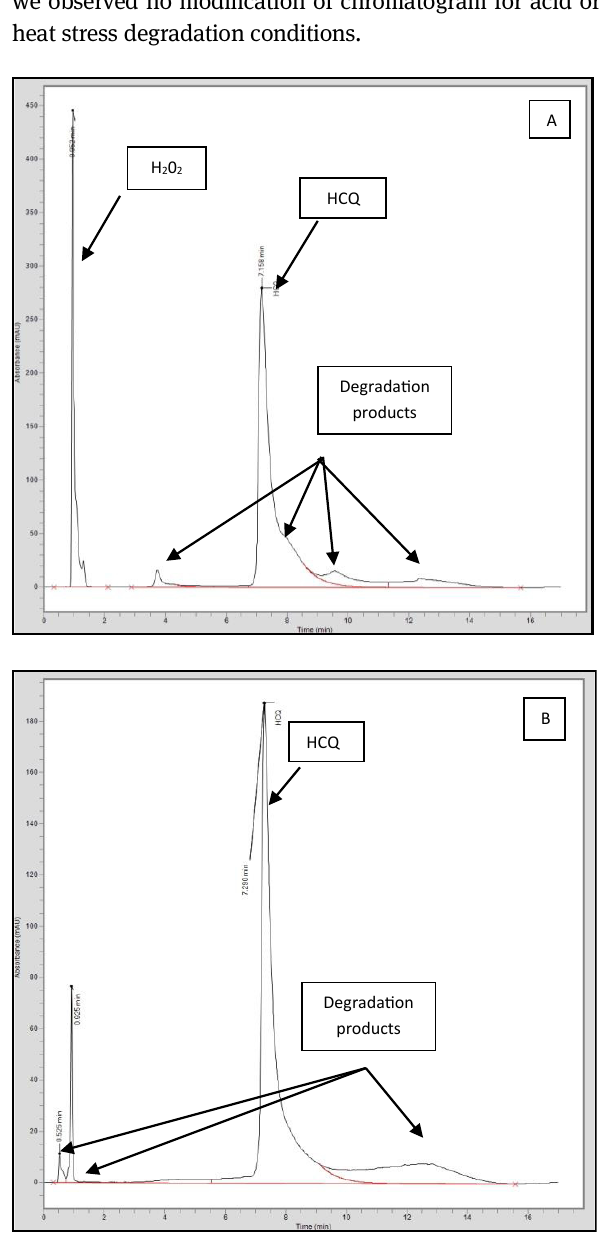
Figure 2: Examples of the chromatogram of HCQ standard solution after degradation in different conditions: oxidation condition (H 2 O 2 30 V, 24 h) (A) and alkaline stress condition (NaOH 1 M, 3 h)